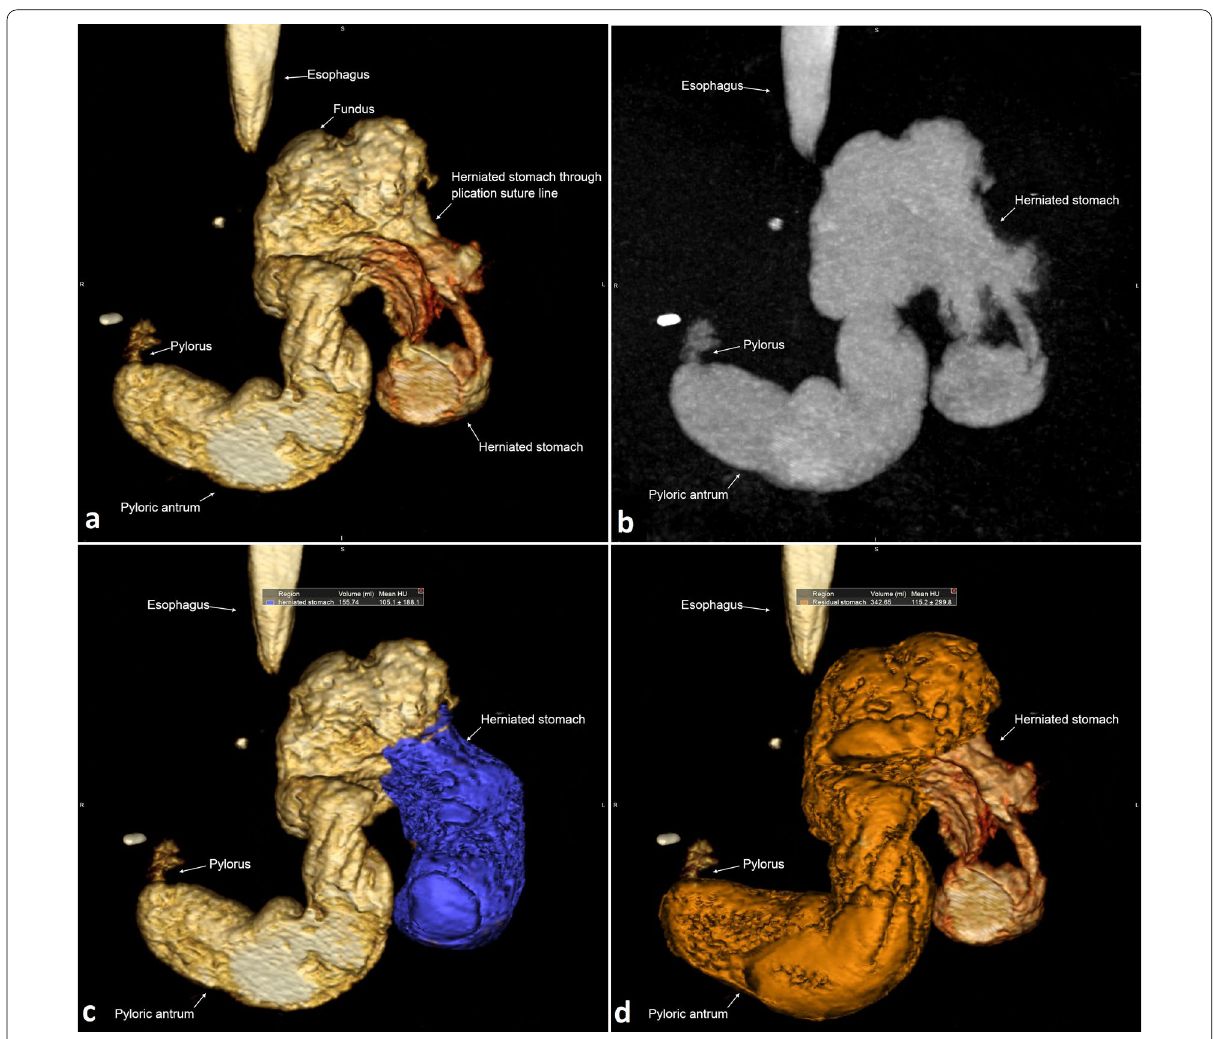
Fig. 6 Gastric plication is complicated with gastric herniation through plication sutures. Sizeable part of gastric body is seen herniating laterally through a plication suture line at the proximal part of greater curvature. Such abnormality is well depicted at 3D volume rendered image ( a ) and MIP image ( b ). The volume of the herniated part (155.7 ml) could be measured using CT gastric volumetry ( c ). The remaining gastric pouch is significantly dilated as well ( d ), its volume 342 ml. Retained food particles was demonstrated within the herniated part of the stomach on = reviewing axial dataset (not